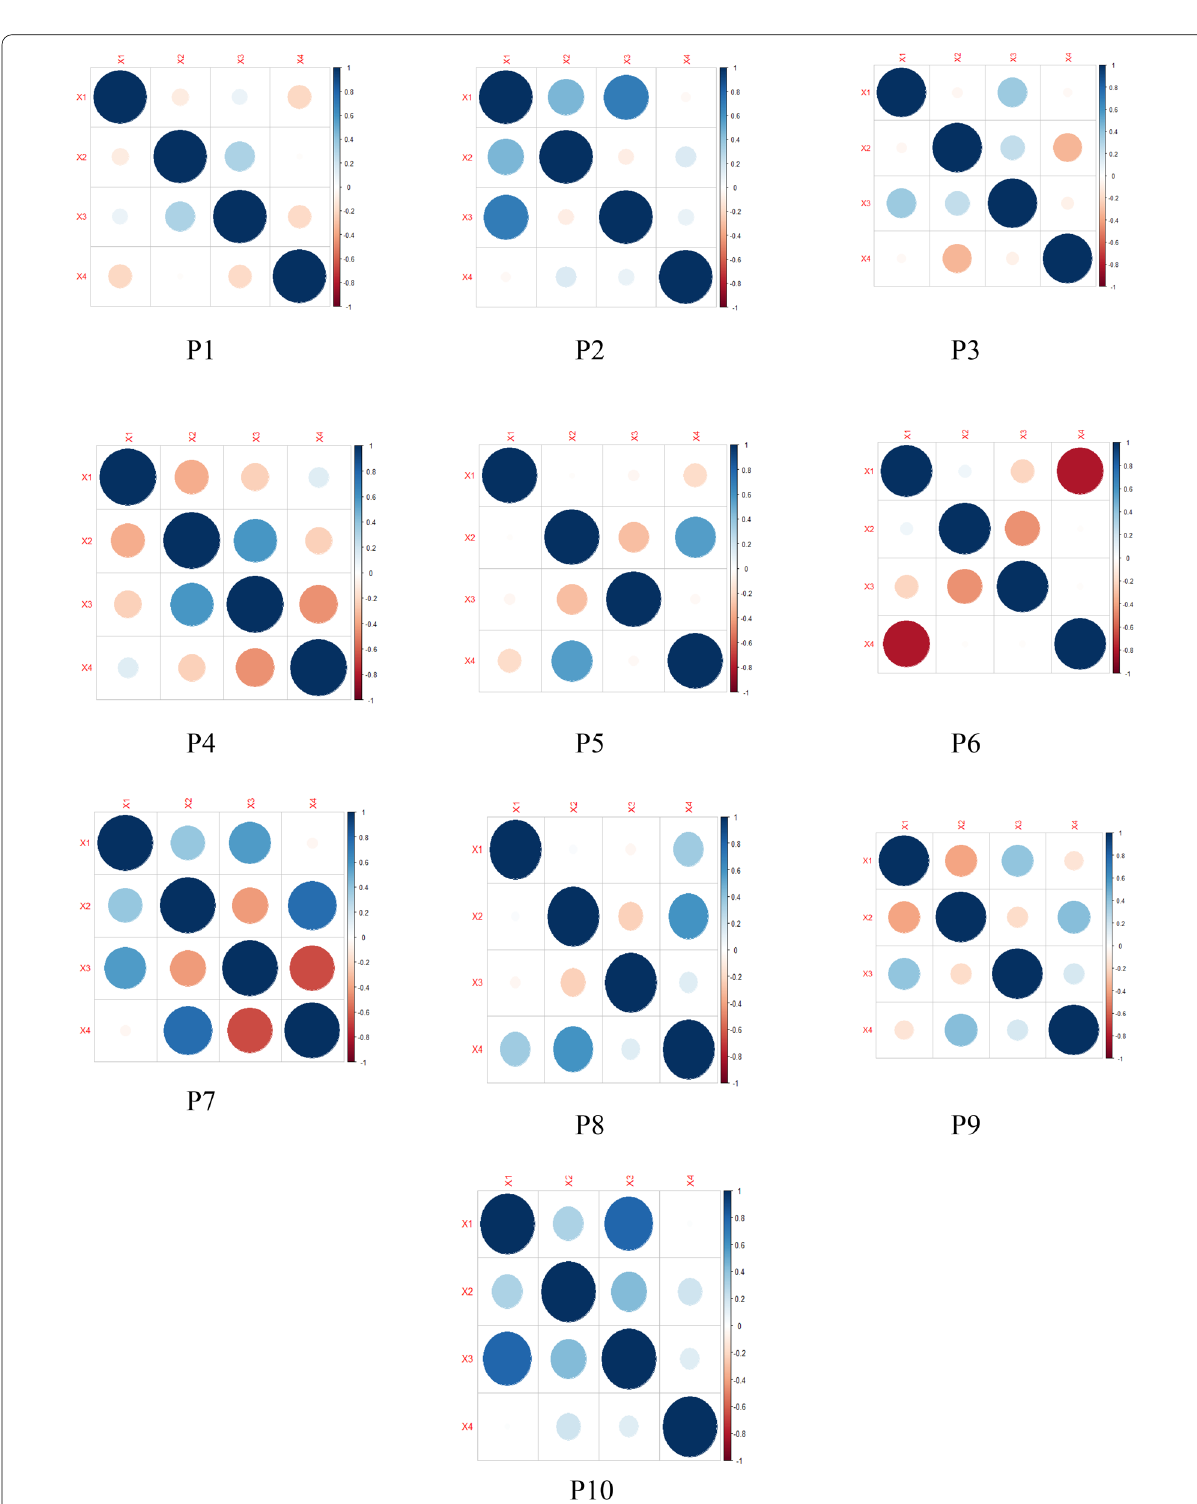
Fig. 4 Correlation analysis of morphometric parameters and quantitative indicators of specimens within P1–P10 populations. Correlations with P < 0.05 are highlighted in color. The color indicates either positive (blue) or negative (red) correlation. (X1: Number of adult specimens per 1 m 2 ; X2: Height of generative species at the time of bloomingg (cm); X3: The number of sprouts per a specimens (pcs); X4: Inflorescence diameter